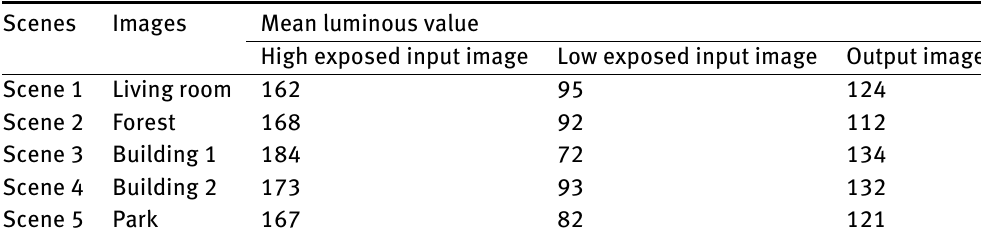
Table 3: Mean value for the input and output images